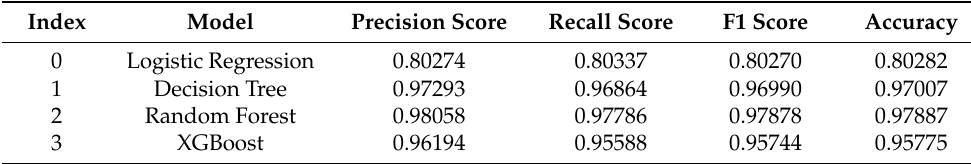
Table 2. Evaluation metrics on up-sampled